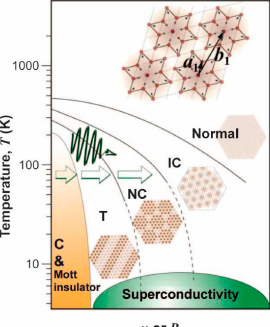
Figure 2. Phase and electronic structures of TMDs. General phase diagram of 1T-TaS 2 in different physical domains (temperature, doping x(Fe), or pressure P). Where C refers to commensurate CDW, T refers to triclinic incommensurate CDW, NC refers to near commensurate and IC refers to incommensurate CDW. The phase evolution of a CDW can be characterized by the variation of the hexagonal CDW diffraction peak at the inverse vector Q (upper right corner). The upper right corner shows the SD 13-cluster, representing the C-CDW cells in real space. Lattice distortion within each star is coupled with strong charge density redistribution. Reproduced from [45], with the permission of the AAAS.